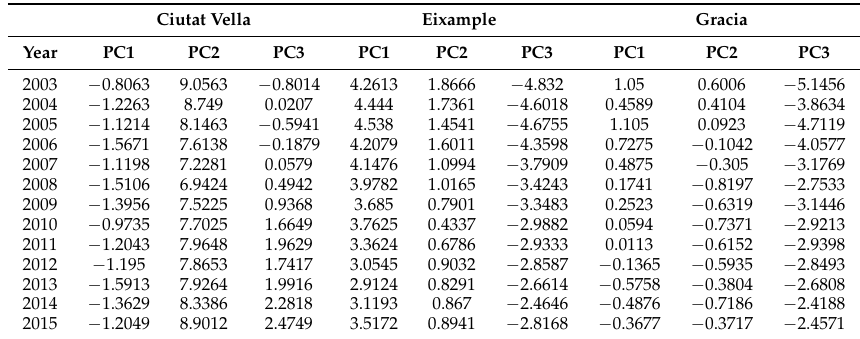
Table A1. Coordinates (seen as the component loadings of the PCA analysis) for the ten districts in the temporal